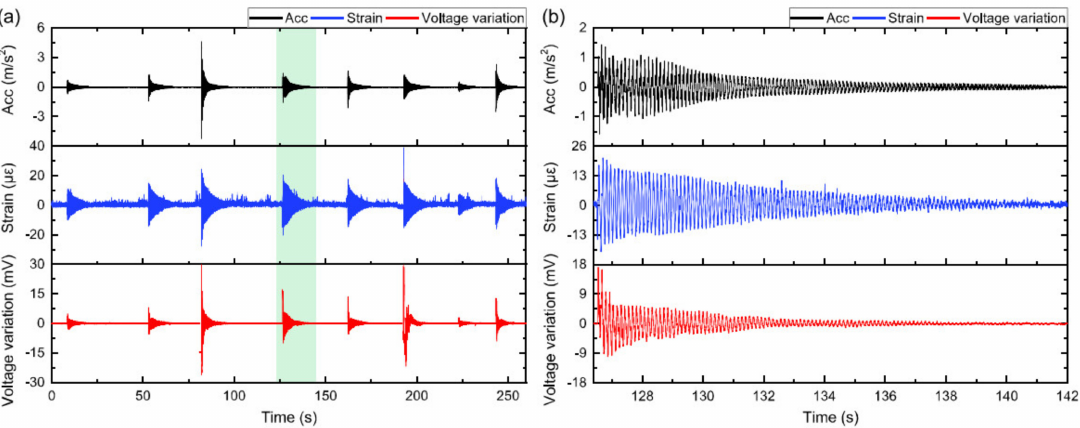
Figure 29. ( a ) Response of HNCS during the hammer impact test; ( b ) response-decaying curves for three sensors during the test. Reproduced with permission from [29], IOP Publishing Ltd.,